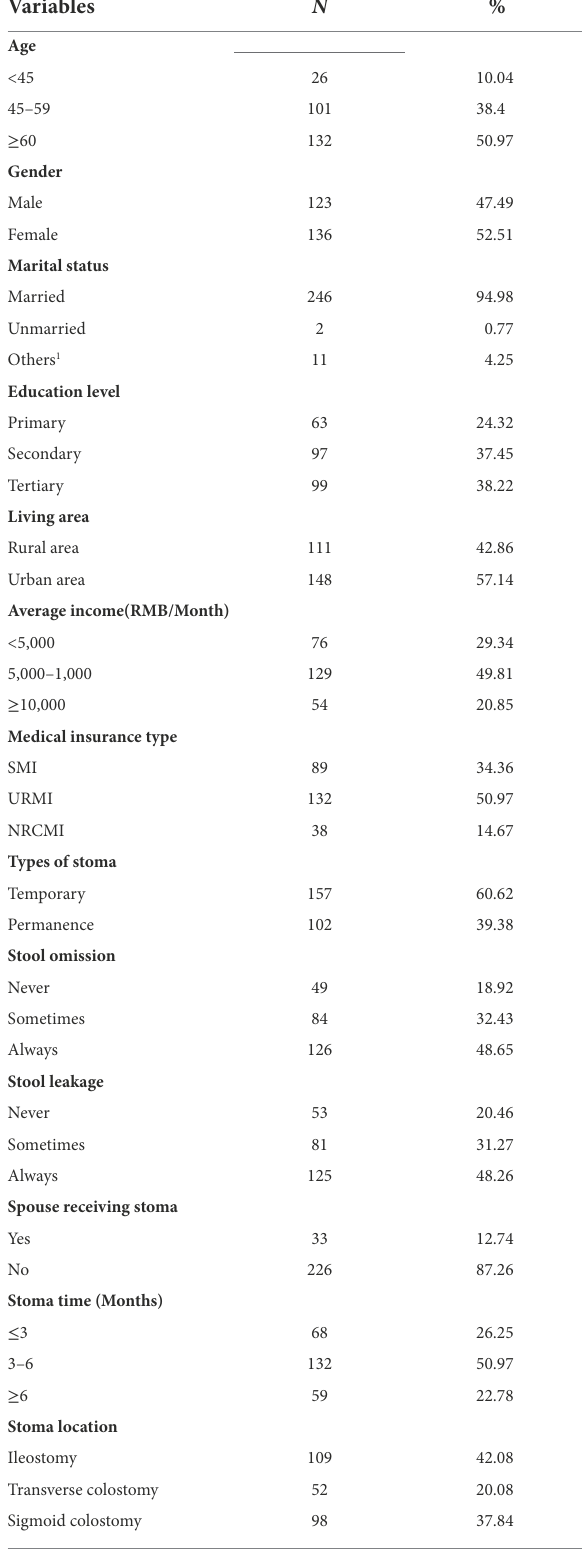
TABLE 2 Sociodemographic and clinical characteristic of the sample ( N = 259).